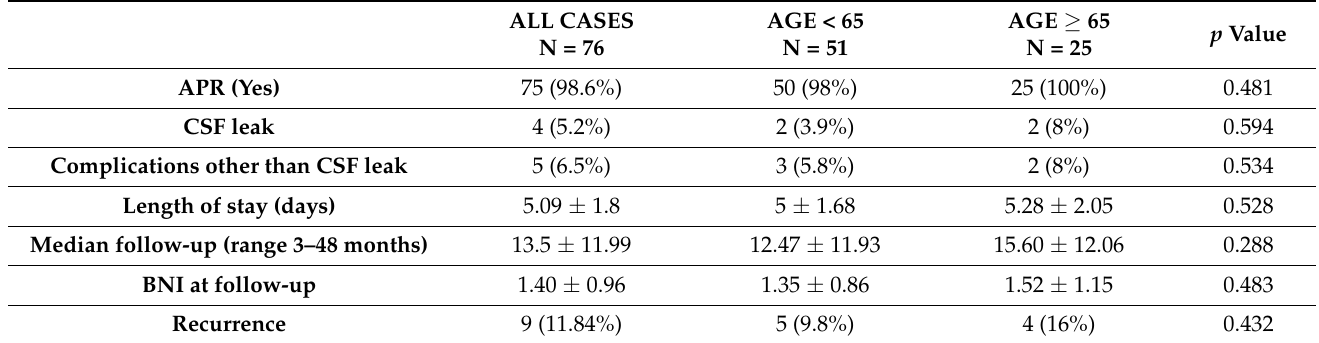
Table 3. Outcome data comparison.